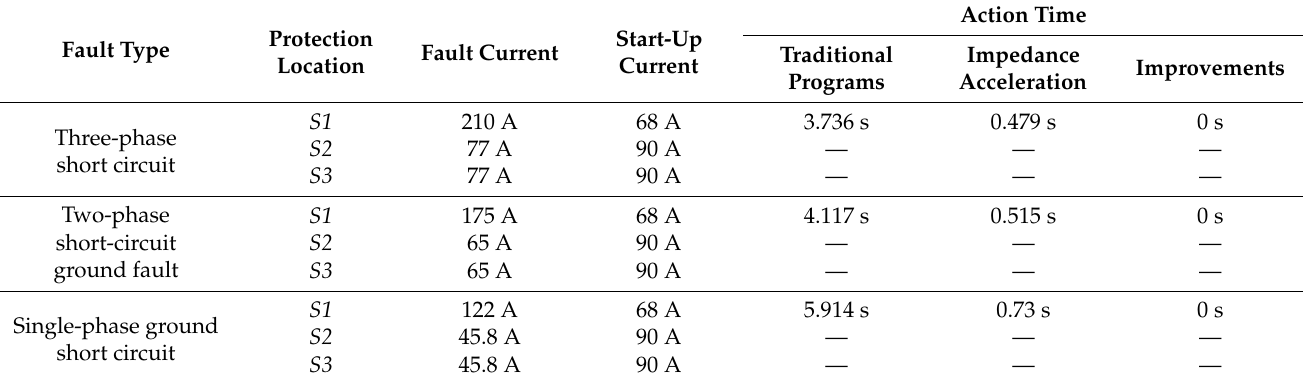
Table 10. Operating time of different protection schemes in the case of line AB via 50 Ω ground resistance fault.